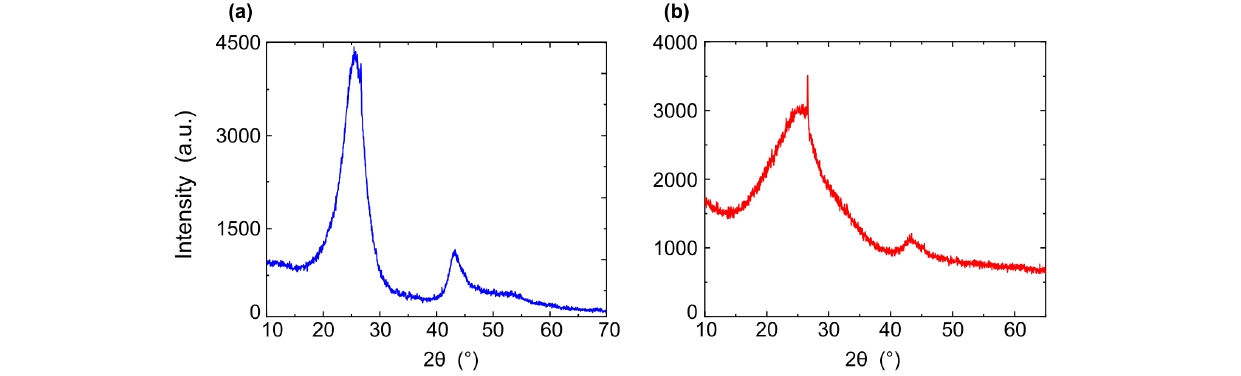
Figure 7. X-ray spectra of shungite ( a ) sample before sonication, ( b ) sample after